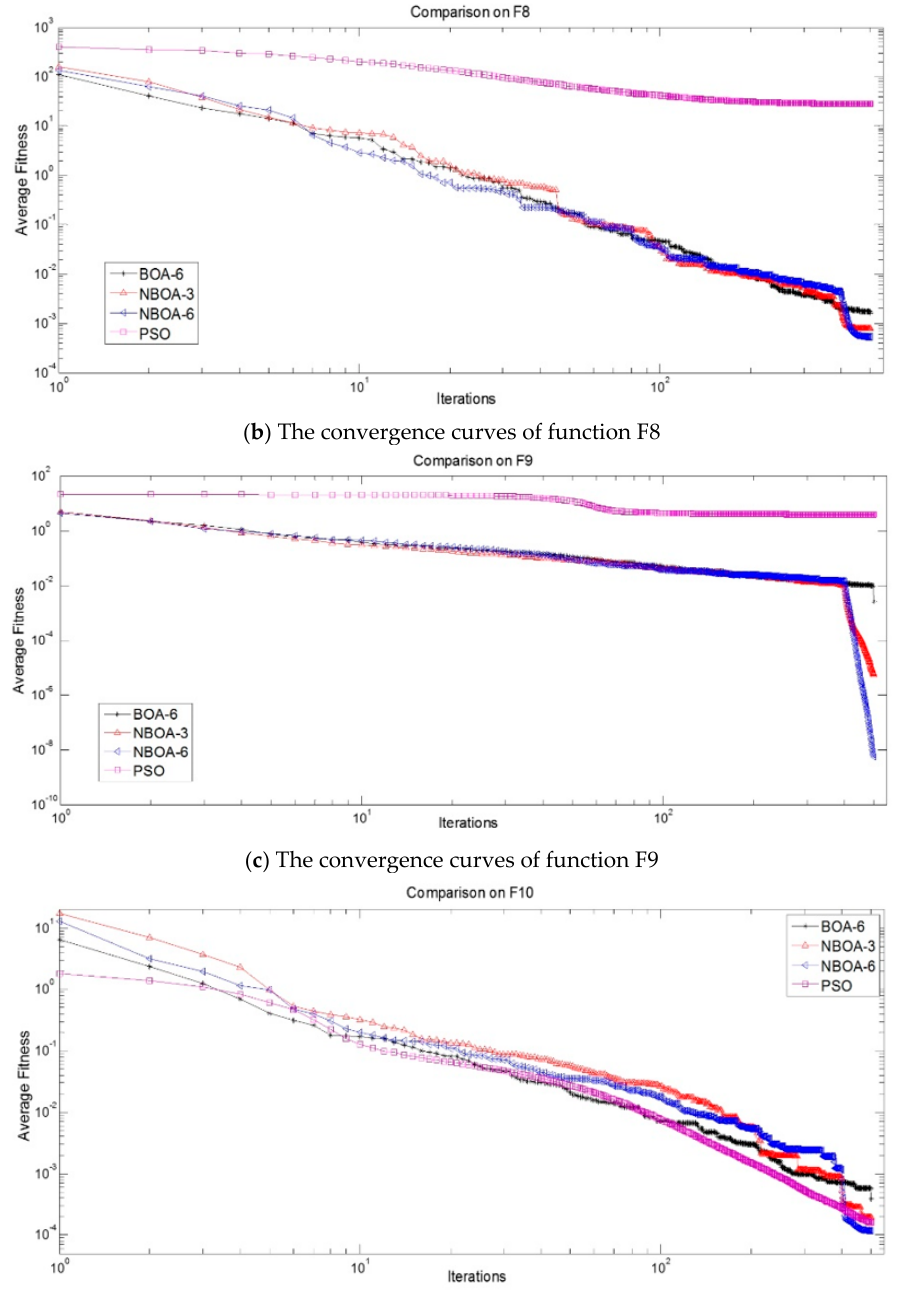
Figure 3. The convergence curves of multimodal functions: The curves of BOA-6 are black, the curves of NBOA-6 are blue, the curves of NBOA-3 are red, and the curves of PSO are purple. All the curves are average convergence curves for 50 computational iterations, and in order to show the curves more clearly, the coordinates were changed by logarithmic processing.